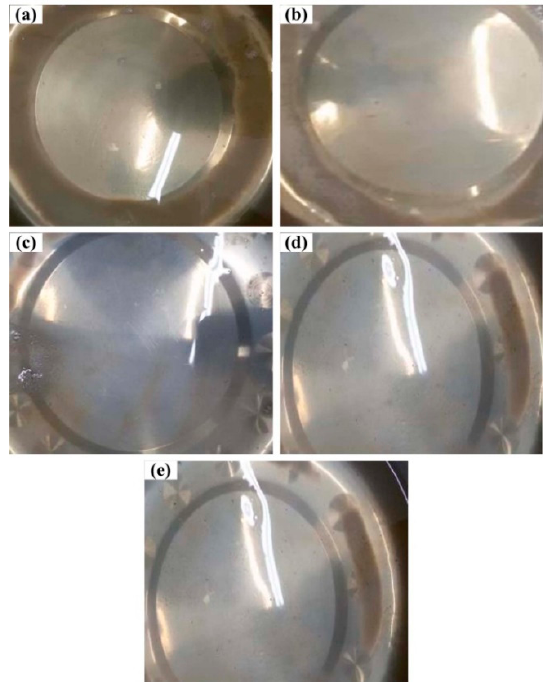
Figure 3. Liquid PEWs prepared under different screw speeds at the pyrolysis temperature of 693 K.